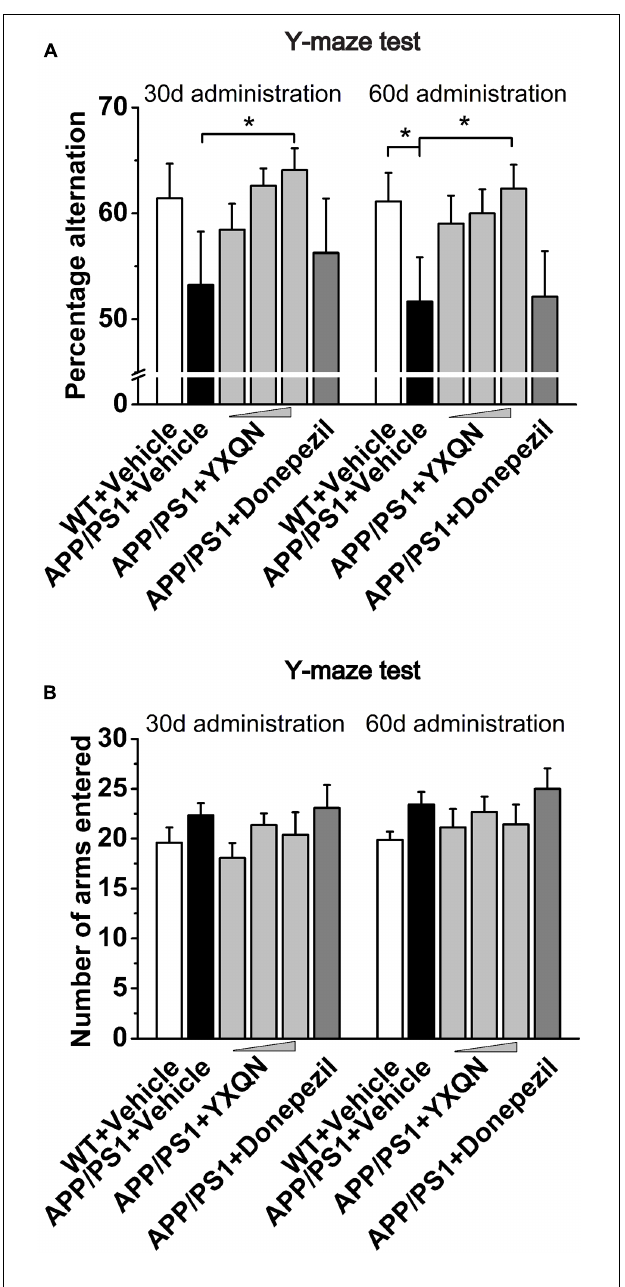
FIGURE 3 | Yangxue Qingnao improves the short-term spatial memory decline in APP/PS1 mice by Y-maze. (A) Short-term spatial memory observed twice (administration 1- or 2-month) by percentage alternation among arms in WT mice ( n = 16) and the APP/PS1 mice with vehicle, YXQN or donepezil administration ( n = 14–17). (B) Total arm entries of individual groups. The drug dosages from low to high of YXQN extract are 0.69, 2.08, and 6.24 g/kg. Data are represented as group mean ± S.E.M. All post hoc statistical comparisons are versus the vehicle APP/PS1 mice, ∗ p < 0.05 (Dunnet’s post hoc